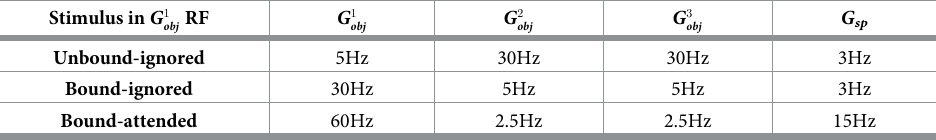
Table 1. Firing rates of model G -cells in different stimulus and attention conditions. The labels in the first column refer to the stimulus and attention conditions in the RF of G 1 . Numbers in other columns are firing rates of G cells obj that are described in the first column. listed in the first row of the respective column, under conditions in the RF of G 1 obj Stimulus in G 1 RF G 1 G sp G 2 G 3 obj obj obj obj Unbound-ignored 5Hz 3Hz Bound-ignored 5Hz 3Hz Bound-attended